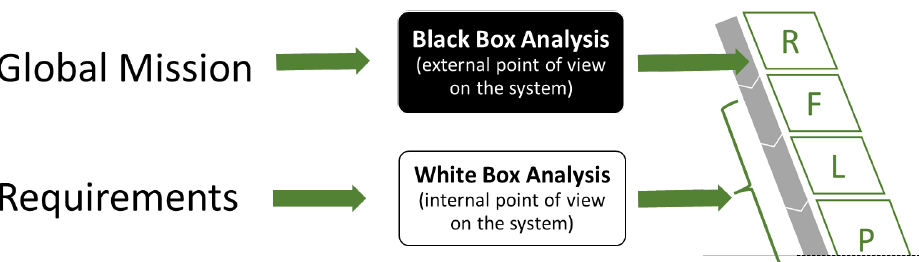
Figure 7. BBA and WBA linked to the RFLP